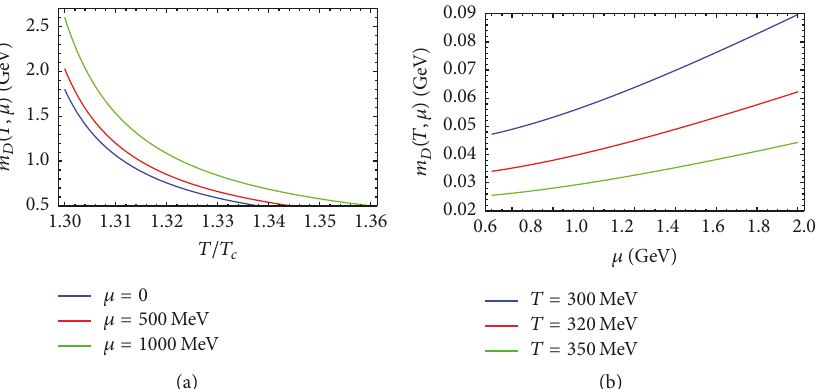
Figure 3: Debye screening mass with the temperature at different values of chemical potential (a) and Debye screening mass with chemical potential at different values of temperatures